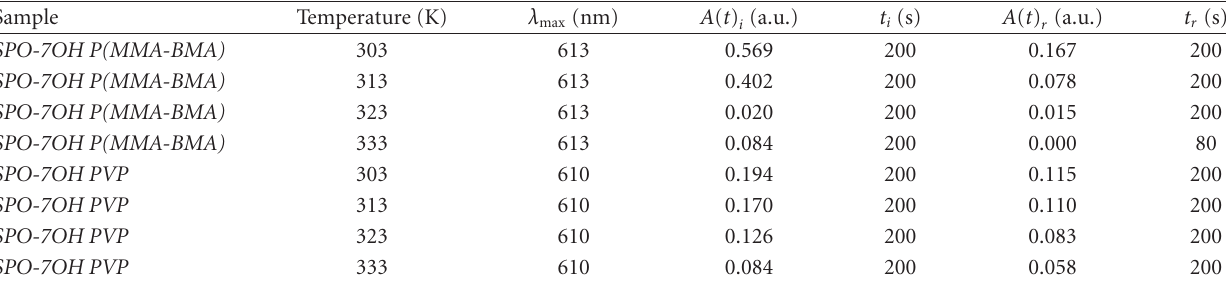
Table 1: Spectral parameters of SPO-7OH in polymers matrices.